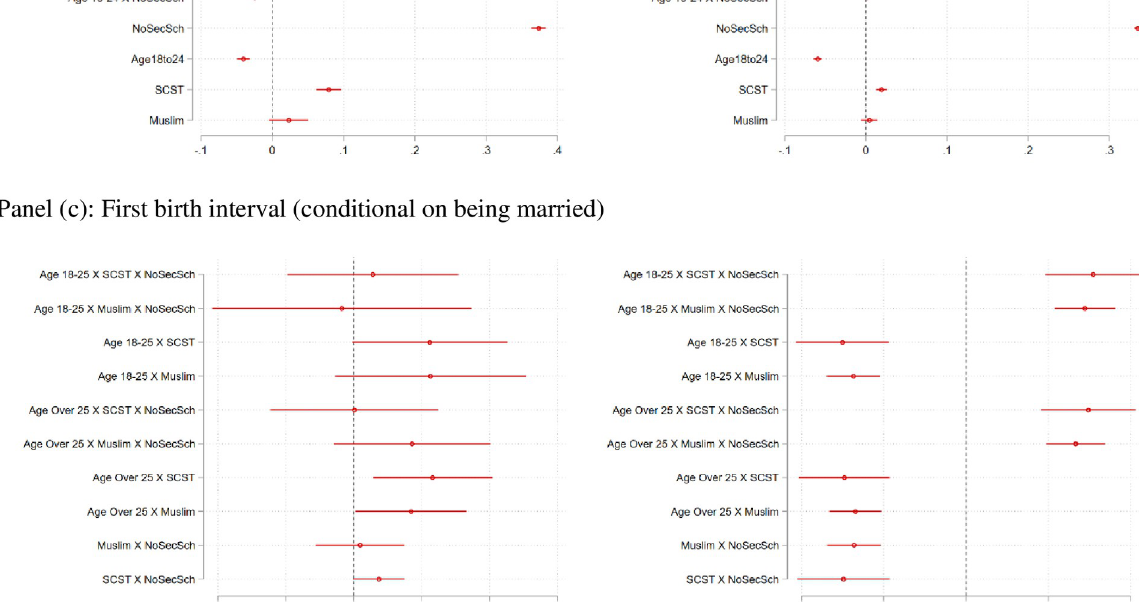
PLOS ONE | https://doi.org/10.1371/journal.pone.0242876 December28,